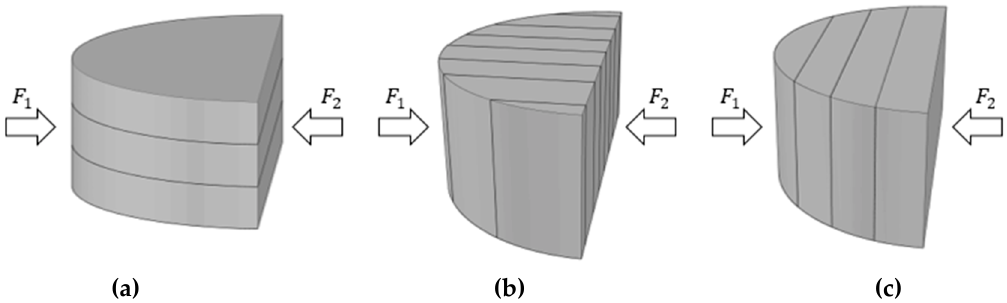
Figure 3. Three loading configurations tested. ( a ) Crack-divider, ( b ) Crack-splitter, ( c ) Crack-arrester.